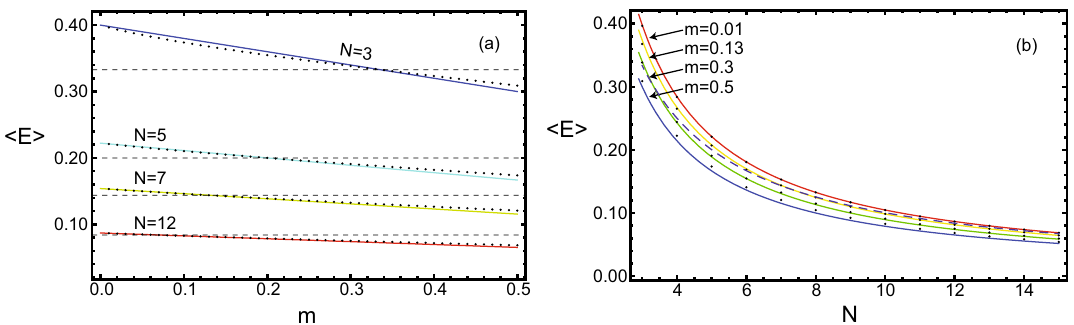
Figure 4. Dependence of the mean energy of selected particle: ( a ) on its mass m for a fixed number of particles in the vessel. ( b ) on the number of particles N for a fixed mass of selected particle. All other particles had equal masses. The dotted lines show the energy equipartition level. The dots show the average energy according to both Eq. (8) and the simulation of particle motion, the solid lines show the approximate formula Eq. (9). The dependence of the particle’s mean energy on its mass is very visible, in contrast to the energy